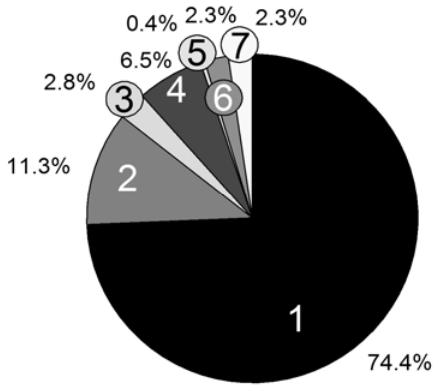
Figure 14. Persistence simulation time; 1: Update R reaction ( X ); 4: Propagation; 5: TransferCopolymer_PL-P; 6: TransferCopolymer_P-PL; i 7: calculate τ .